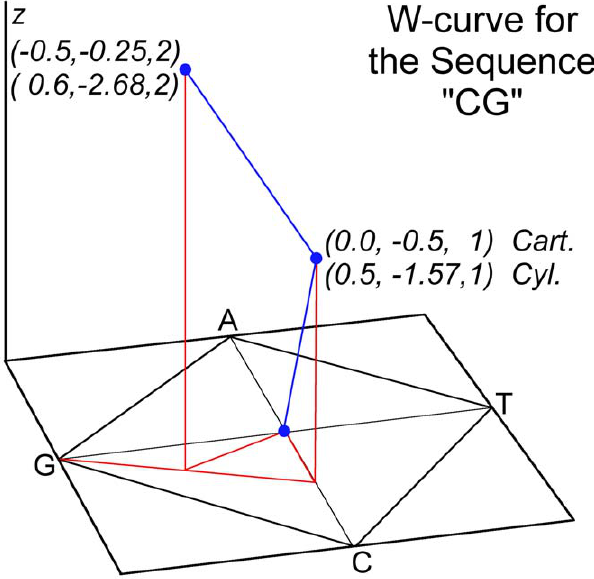
Figure 6. The W-curve for ‘‘CG’’ showing both Cartesian & Cylindrical notation for the points. The curve is shown in blue, layout lines indicating the X-Y locations and line for half-distance rule between the points for C & G are shown in